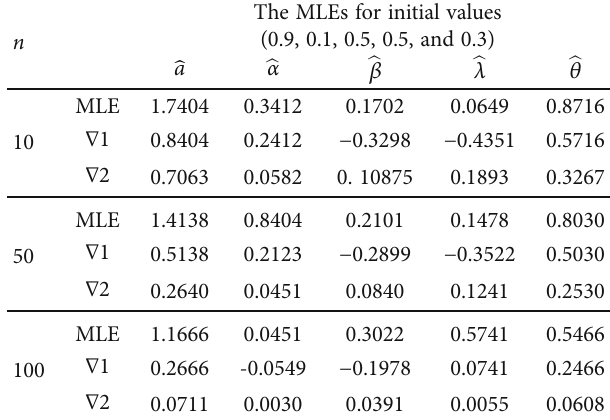
Table 4: The values of MLE, ∇ 1 , and ∇ 2 for the